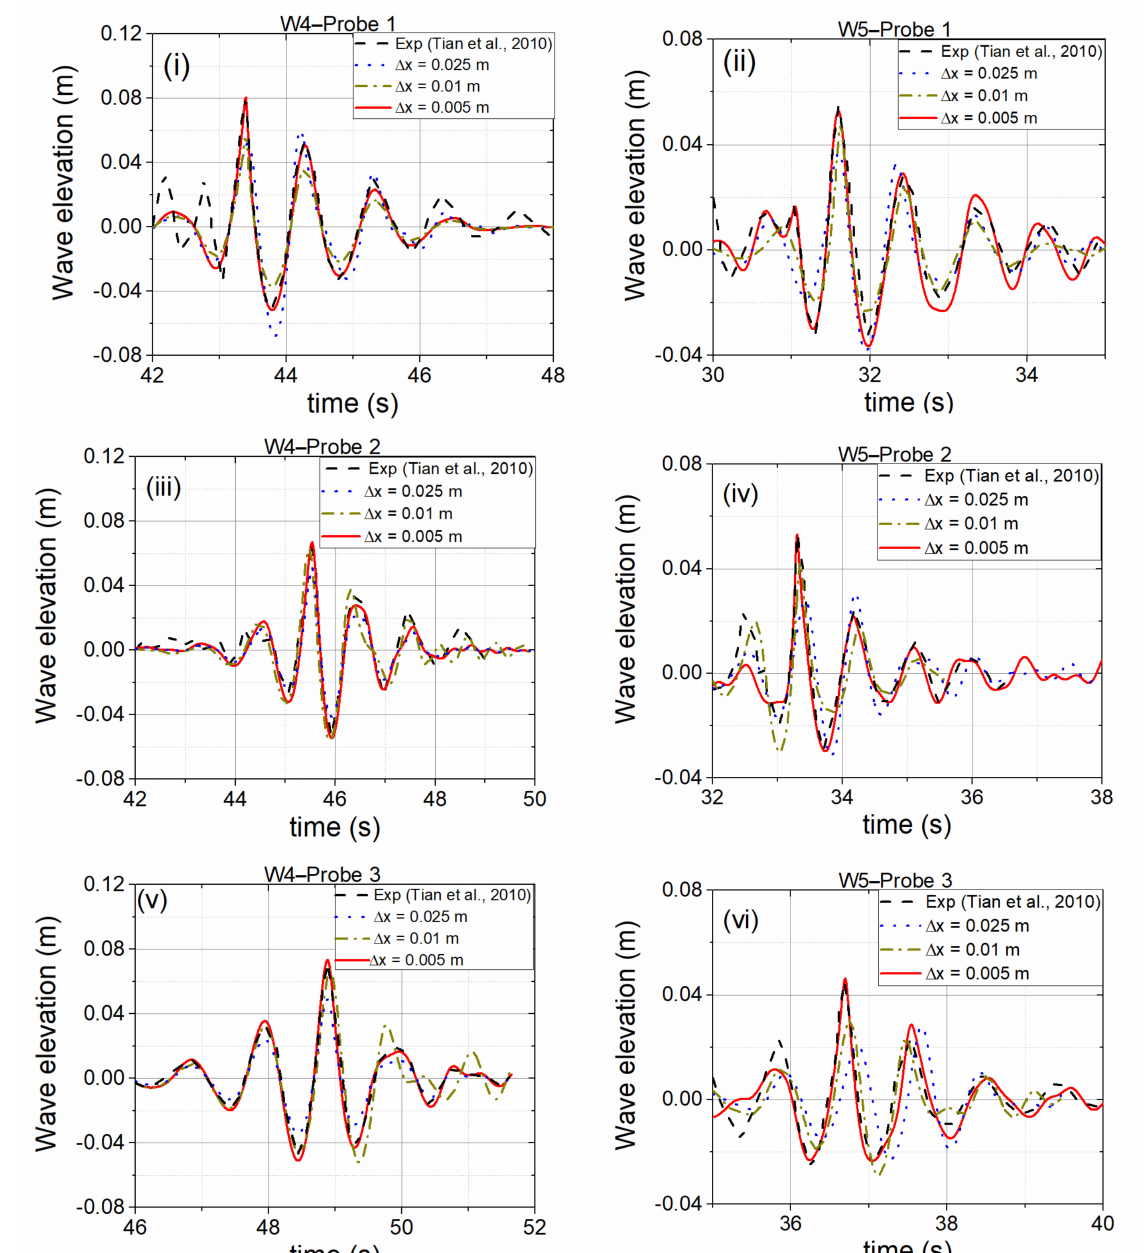
Figure 5. Comparison of experimental results of [31] with different mesh sizes of 0.025, 0.01, 0.005 m from wave ids W4 and W5 ( i )W4-Probe 1 ( ii ) W5-Probe 1 ( iii ) W4-Probe 2 ( iv ) W5-Probe 2 ( v ) W4- Probe 3 and ( vi ) W5-Probe